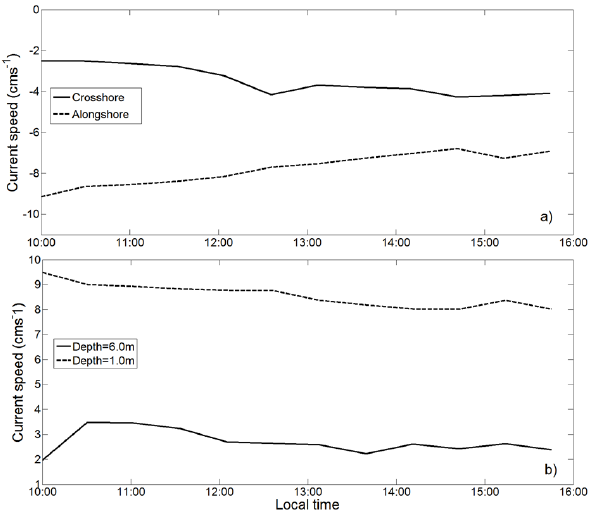
Figure 9: (a) Alongshore and crossshore current velocity component and (b) speed at 1.0 and 6.0 m of depth (January).